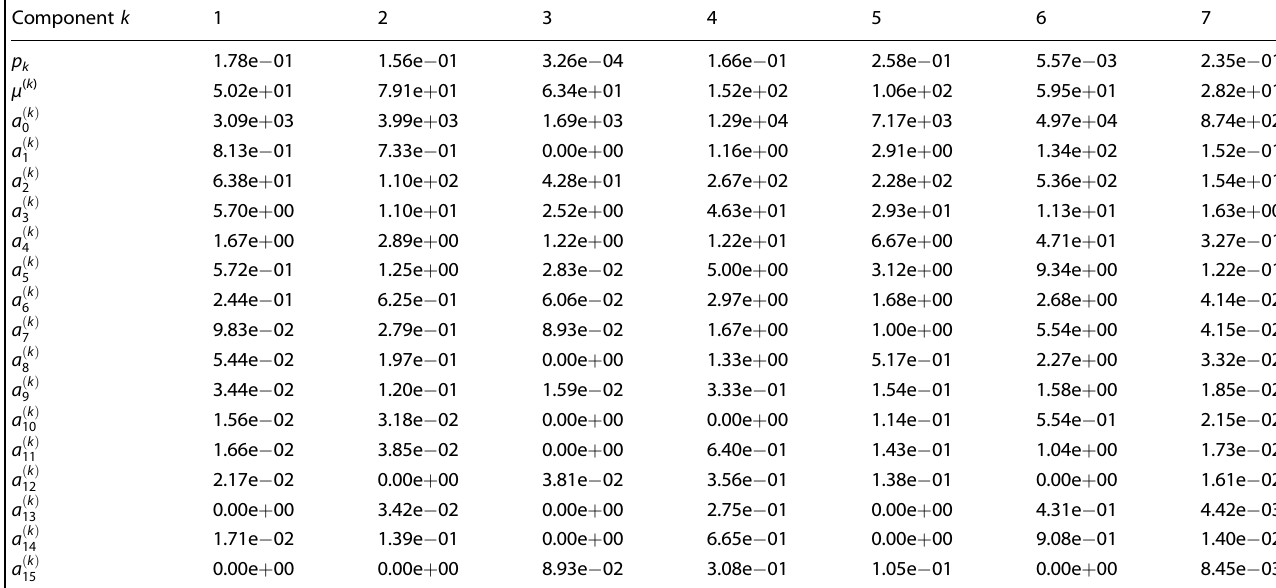
Table 1. Model parameters of the fi tted Gaussian mixture model { X ( u ) : u 2 S 2 }. Component